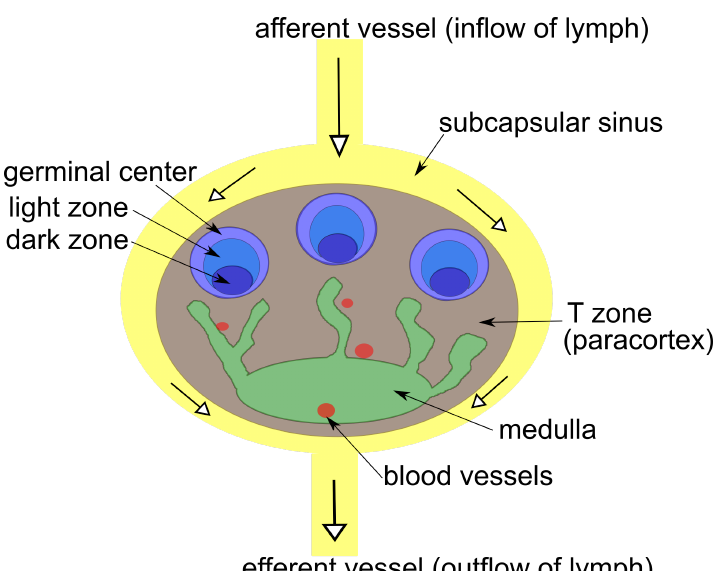
Figure 1. Sketch of a lymph node as a structured organ with compartments: blood vessels (red), subcapsular sinus (yellow), medulla (green), T zone (brown), and germinal center (light blue) with light zone (blue) and dark zone (dark blue). Lymph enters the subcapsular sinus via the topafferent vessel, flows around the lymphoid compartments, and may enter the T